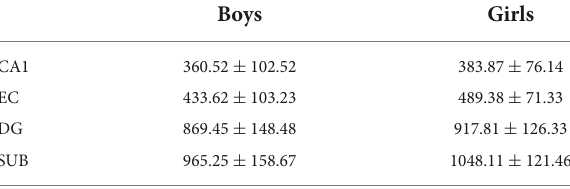
TABLE 4 Mean volumes of hippocampal subfield volumes (in mm 3 ) in boys and